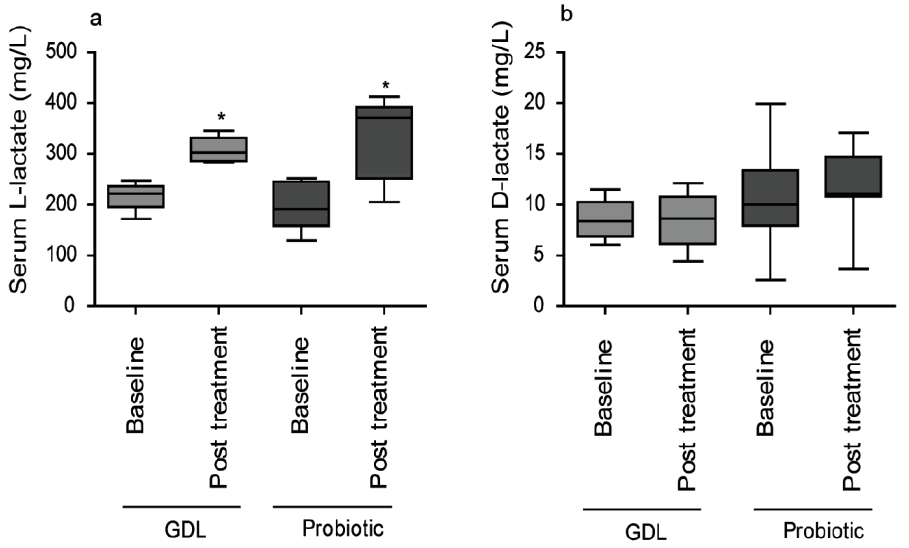
Figure 5. D - and L -lactate measurements. GDL acidified milk patient group ( n = 10). Probiotic milk patient group ( n = 12). ( a ) L -lactate; ( b ) D -lactate. Boxes represent 25th to 75th percentile of data and whiskers represent data spread. Asterisk (*) indicate that post treatment value is significantly different from baseline, P ≤ 0.05. Please note the different scales in (a) and